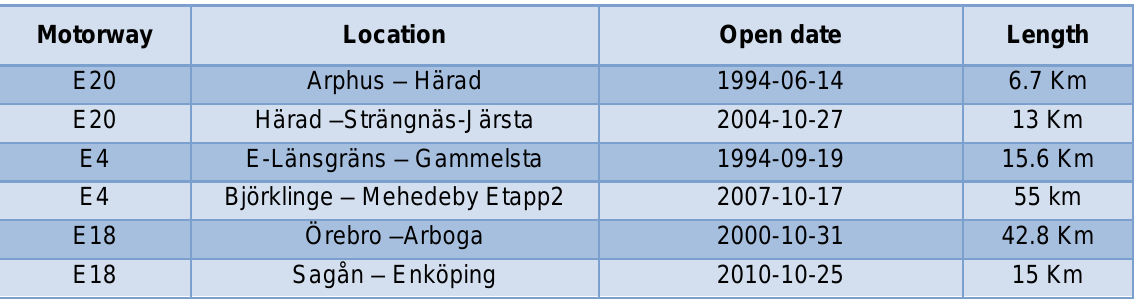
Table 1 Motorway projects